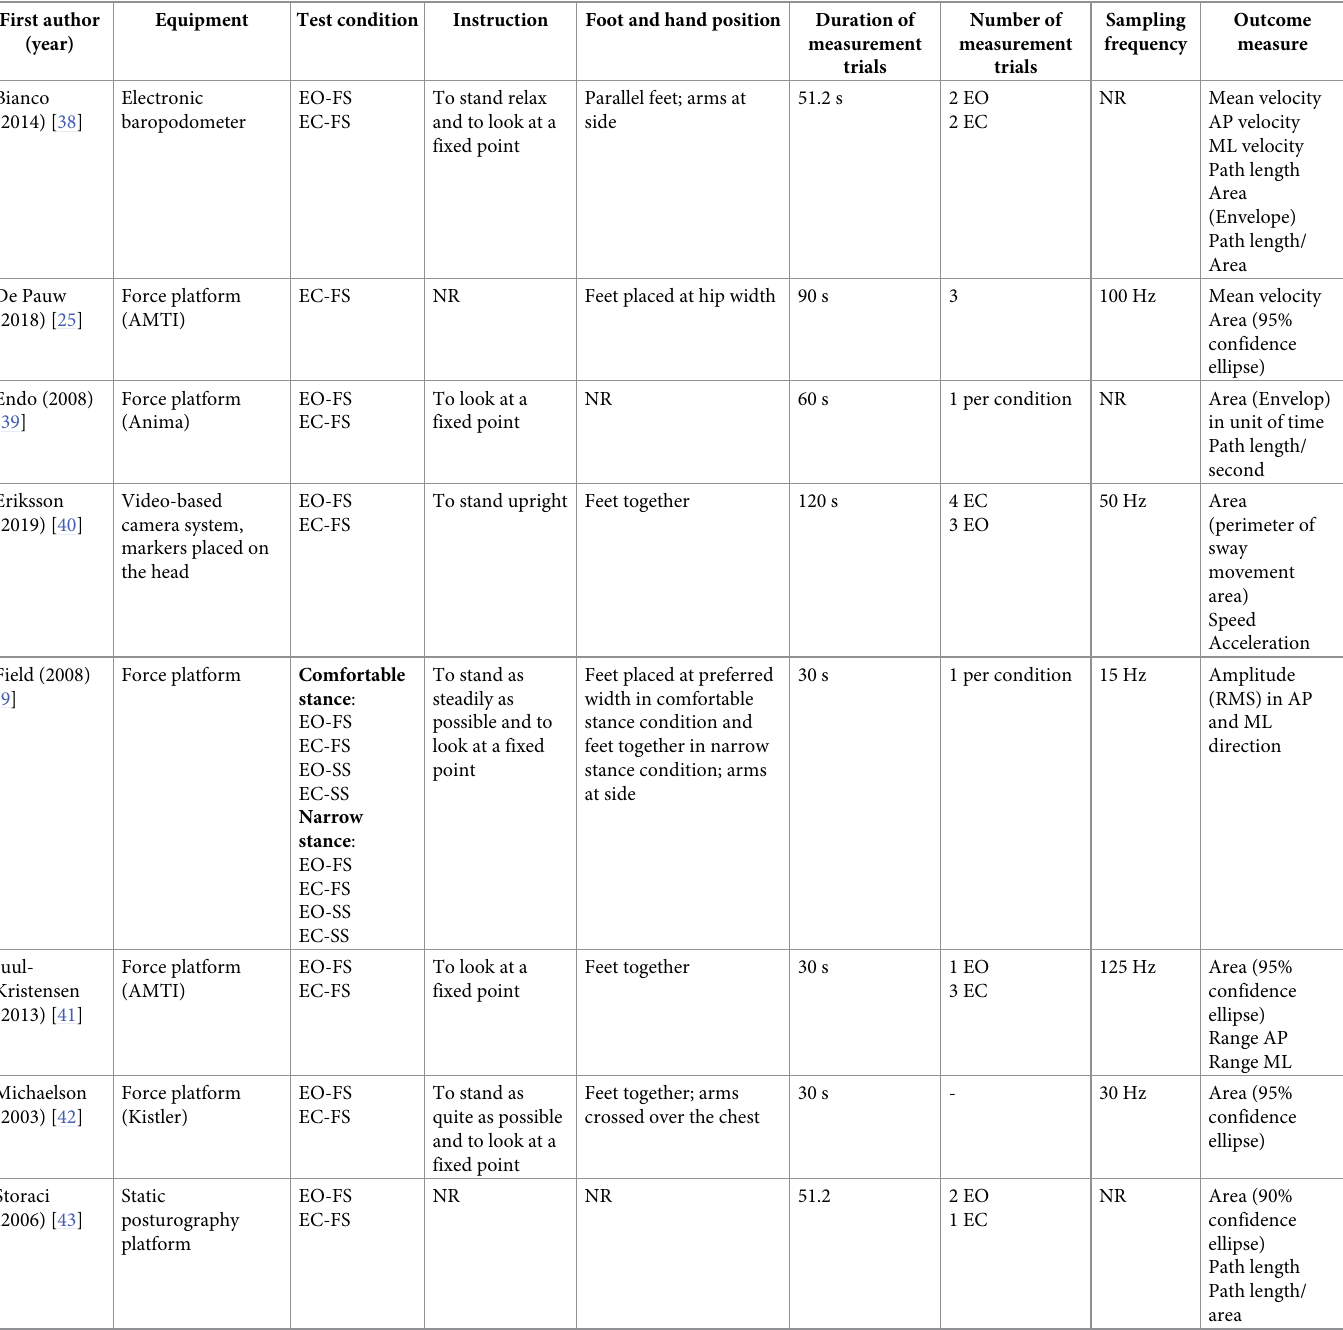
Table 5. Measurement protocol of studies measuring standing